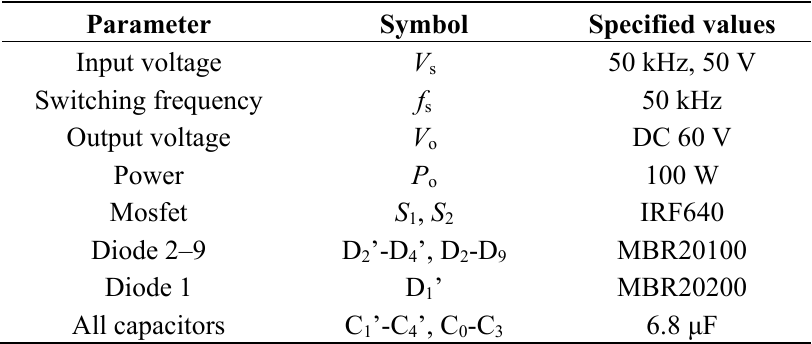
Table 1. Specification of the proposed